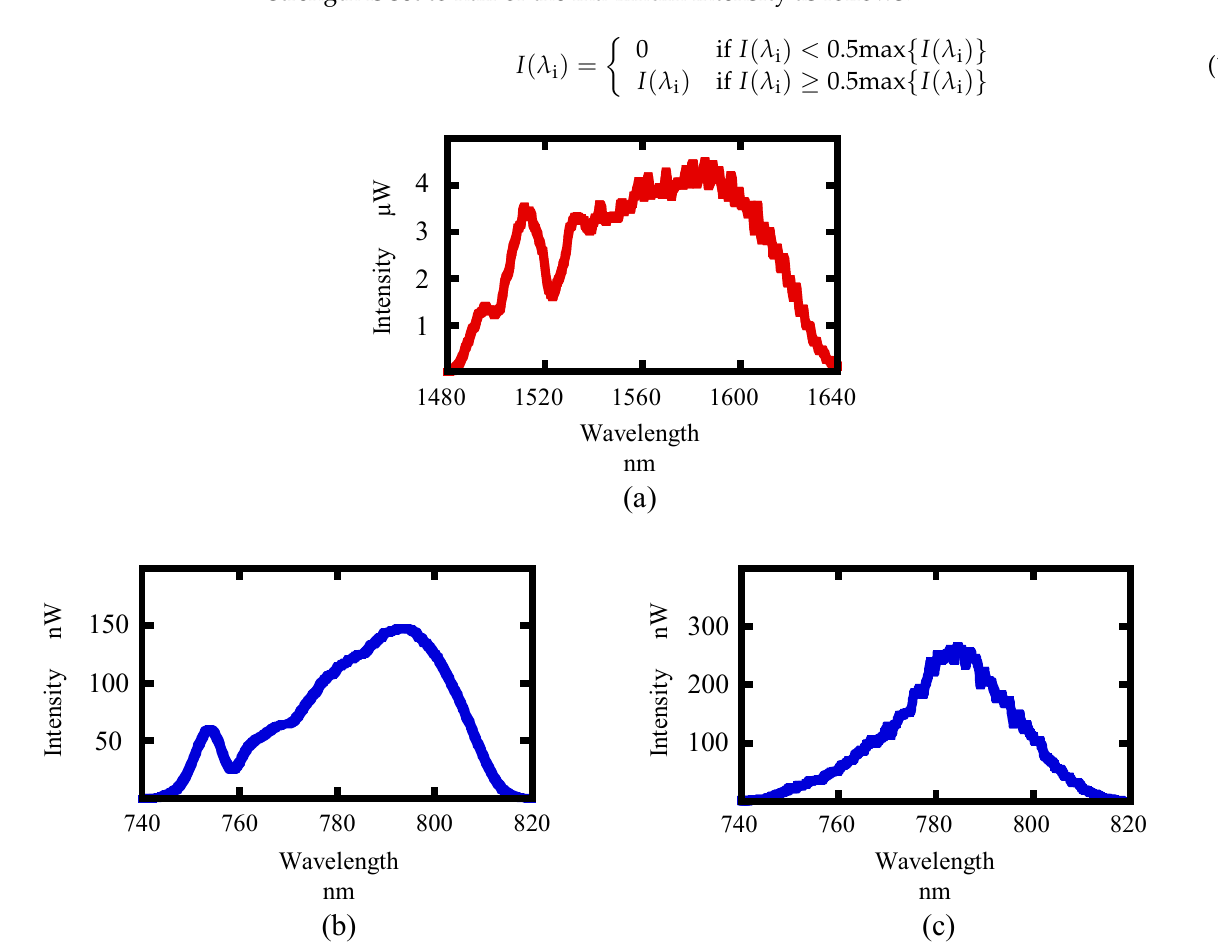
Table 2. BBO crystal characteristics.